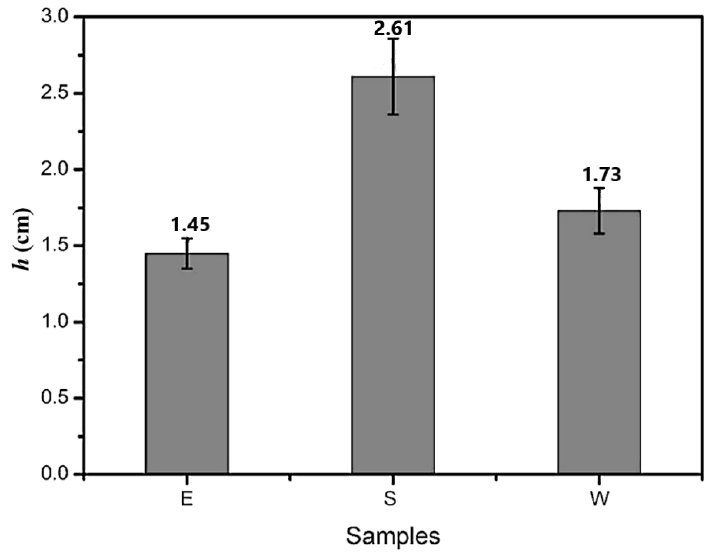
Figure 6. Capillary flow capacity of the three kinds of healing agents (sunflower oil (S), engine oil (E), waste cooking oil (W)).